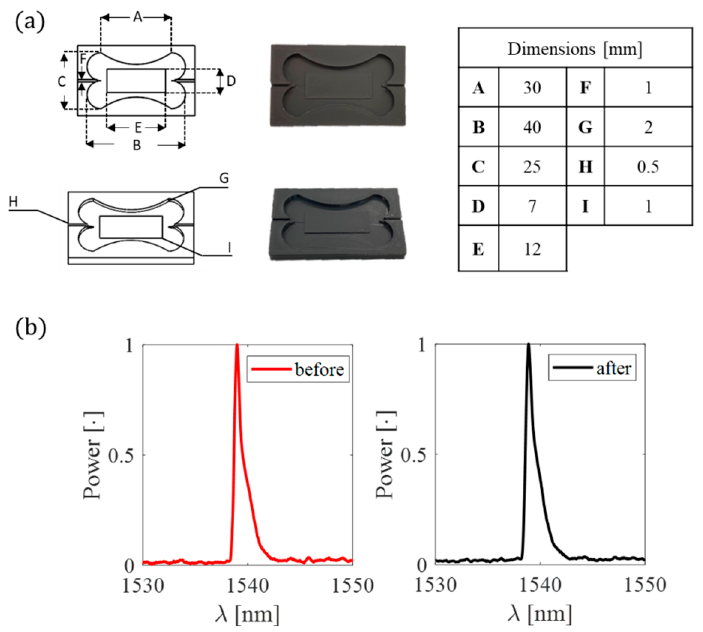
Figure 5. ( a ) Mold geometrical dimensions and ( b ) the spectrum before (red line) and after (black line) the silicone pouring.